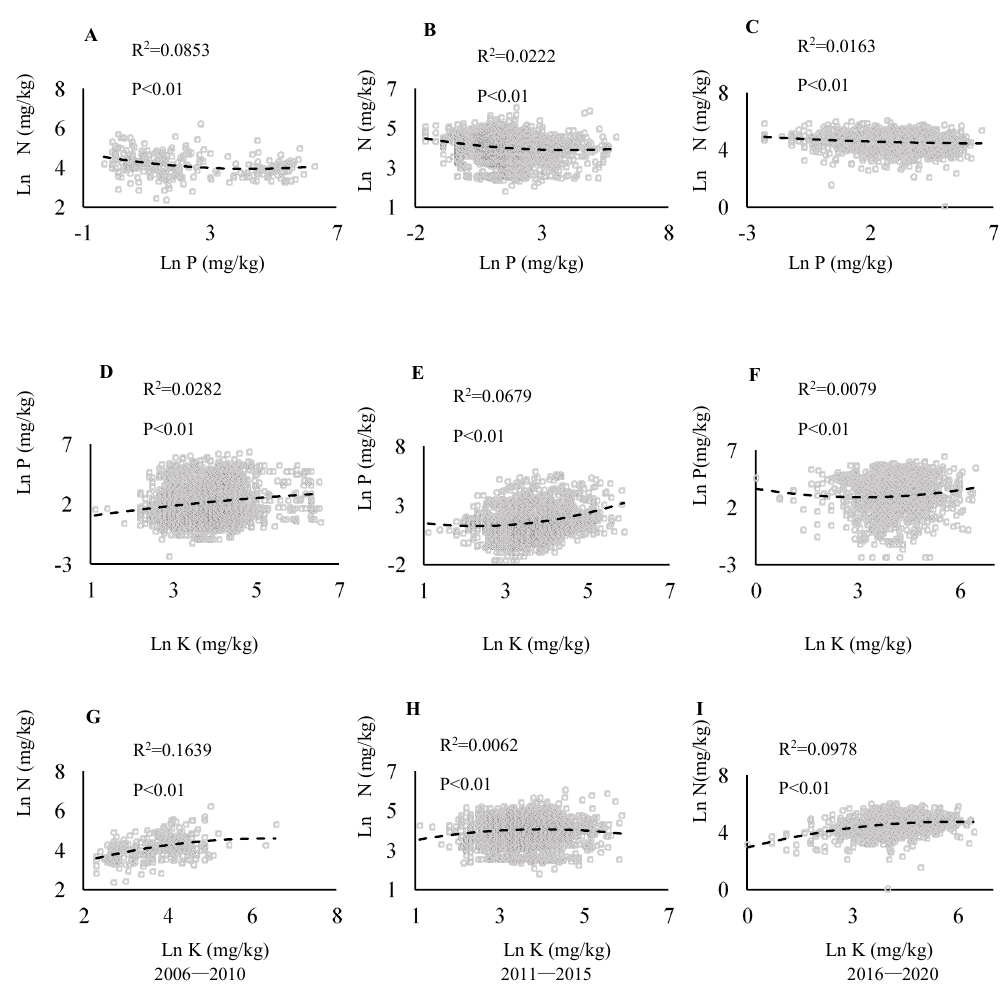
Figure 6. The relationship between available nitrogen and available phosphorus ( A ) for the 2006– 2010 time period. The relationship between available nitrogen and available phosphorus ( B ) for the 2011–2015 time period. The relationship between available nitrogen and available phosphorus ( C ) for the 2016–2020 time period. The relationship between available phosphorus and available potassium ( D ) for the 2006–2010 time period. The relationship between available phosphorus and available potassium ( E ) for the 2011–2015 time period. The relationship between available phosphorus and available potassium ( F ) for the 2016–2020 time period. The relationship between available nitrogen and available potassium ( G ) for the 2006–2010 time period. The relationship between available nitrogen and available potassium ( H ) for the 2011–2015 time period. The relationship between available nitrogen and available potassium ( I ) for the 2016–2020 time period. The gray open circles represent the element concentration, and the broken lines represent the relationship between the elements.